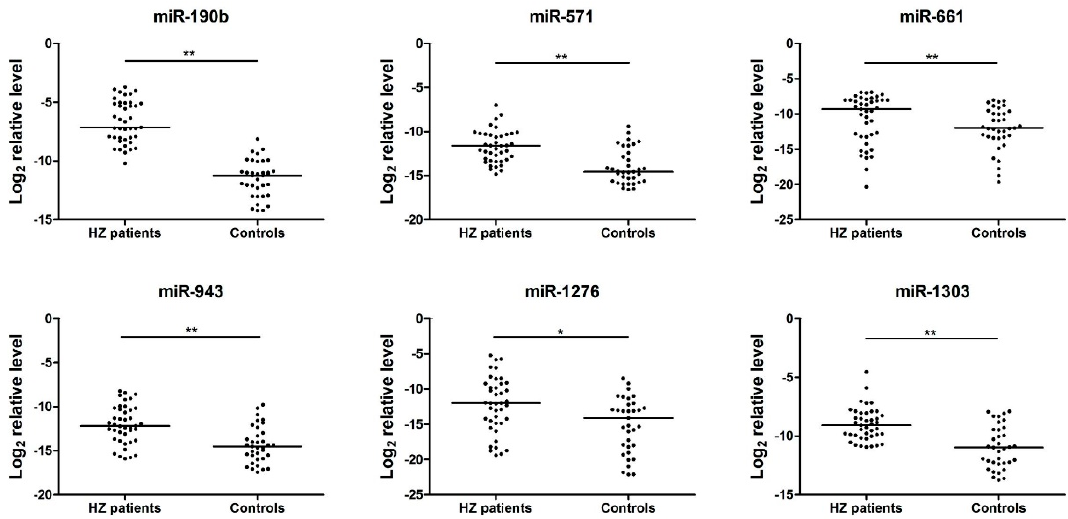
Figure 1. Fifteen serum microRNA (miRNA) levels in herpes zoster (HZ) patients and healthy controls were selected for verification using real-time quantitative reverse transcription PCR (qRT-PCR) in individual HZ patients ( n = 41) and healthy controls ( n = 35). Serum levels of miR-190b, miR-571, miR-1276, miR-1303, miR-943, and miR-661 were significantly higher in HZ patients compared with those in the control group ( * p < 0.05, ** p < 0.01), while no significant differences were detected in the expression of miR-1243, miR-1238, miR-520d-3p, miR-541, miR-1225-3p, miR-605, miR-1, miR-627, and miR-1233 ( p > 0.05). Expression levels of the serum miRNA levels were normalized to cel-miR-39 (spiked-in synthetic miRNA as an internal control). Table 3. AUC and the asymptotic 95% CIs of the individual miRNA in ROC curves. miRNA